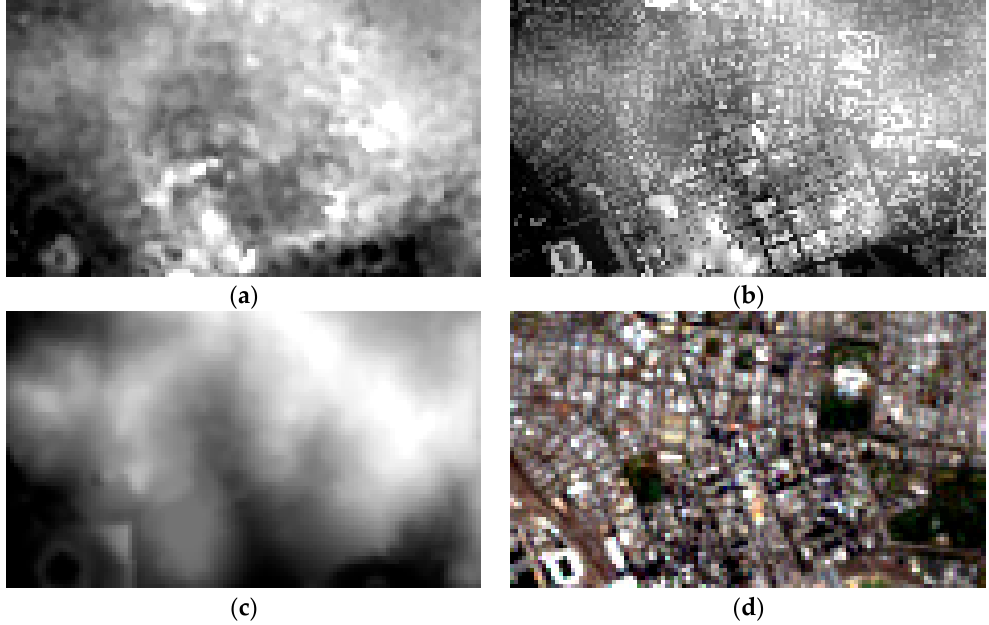
Figure 4. Different types of elevation data in Melbourne city center: ( a ) SRTM; ( b ) DSM; ( c ) JZM; ( d ) 2012 Landsat image.